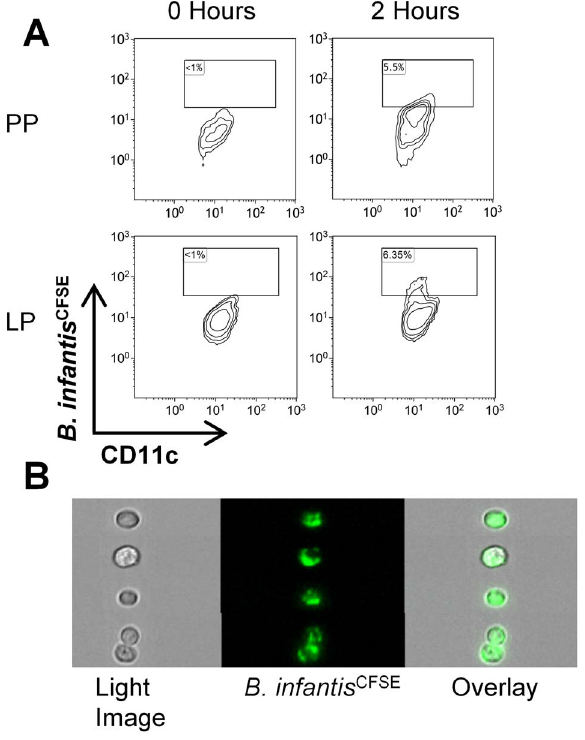
Figure 1. B.infantis is sampled by dendritic cells within PP and LP. ( a ) Flow cytometric analysis of CD11c + MHCII + dendritic cells within the PP and LP at 0 or 2 hours following gavage of CFSE-labelled B. infantis , revealed that a subpopulation of dendritic cells at both sites become CFSE + . ( b ) Visualization by multispectral flow cytometry imaging confirmed the presence of CFSE-labelled bacteria on PP dendritic cells at 2 hours.